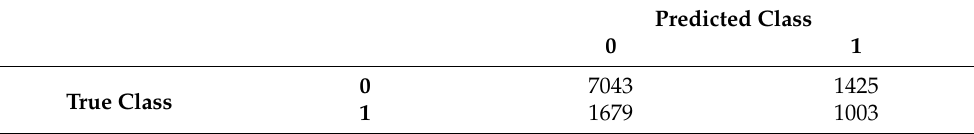
Table 12. Error matrix—Results without